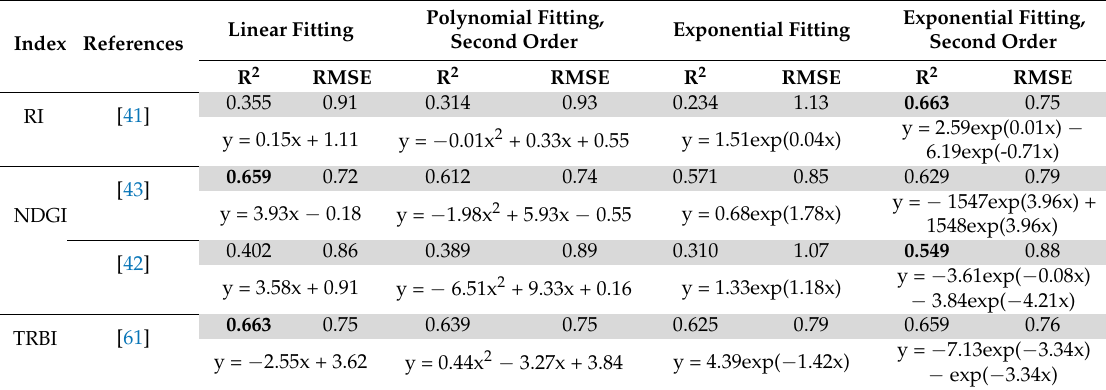
Table 4. Statistics obtained with a linear, polynomial of second order, exponential and exponential of second order fitting for each index. The best fitting is boldfaced.